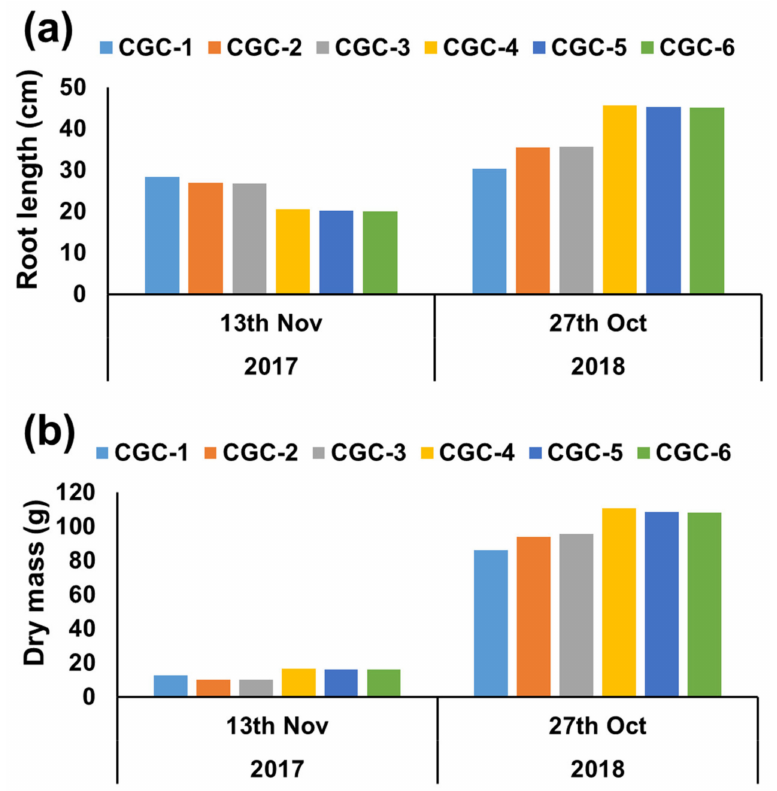
Figure 4. Pinus densiflora seedling root length ( a ) and root dry mass ( b ) affected by different container growth conditions. CGC-1: Control container without modification; CGC-2: CGC-1 with inside 5 mm thick root-turning bump; CGC-3: CGC-1 with inside 10 mm thick root-turning bump; CGC-4: negative phototropism container with a vertical striped slit made on the surface of CGC-1; CGC-5: CGC-4 with inside 5 mm thick root-turning bump; CGC-6: CGC-5 with inside 10 mm thick root-turning